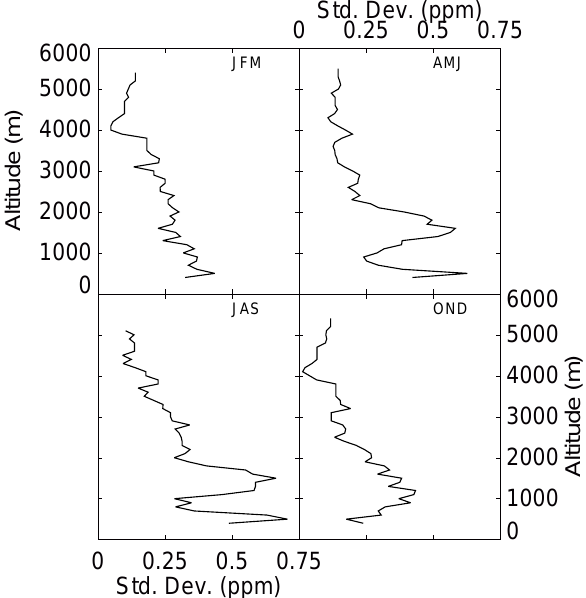
Fig. 13. The standard deviation of the differences in CO 2 mole frac- tion between RM0 and flasks collected between 2007 and 2012. The RM0 data were binned to 1-min averages. Each quadrant of the graph corresponds to a 3-month average climatological vertical